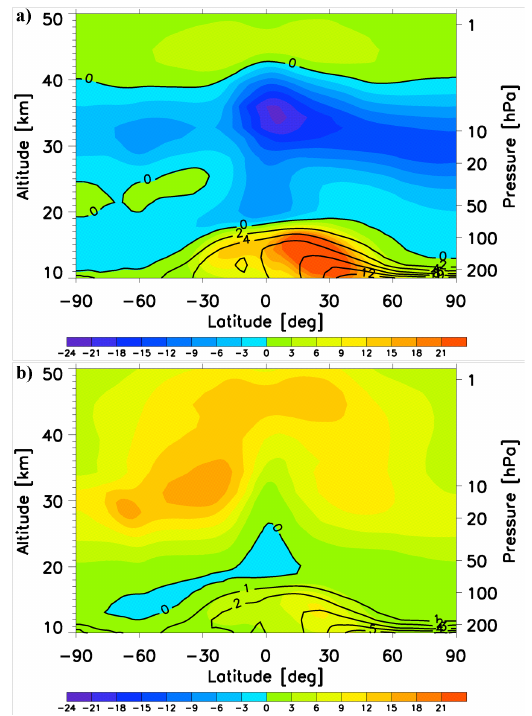
Figure 10. Annually, zonally averaged NO x concentration changes in units of pptv (shown by 2 Fig. 10. Annually, zonally averaged NO x concentration changes in color) and the relative change in % (shown by contours) in the H 2 -ICE scenarios compared 3 units of pptv (shown by color) and the relative change in % (shown with the BL scenarios as a function of latitude and altitude for (a) A1FI and (b) B1 scenarios. 4 by contours) in the H 2 -ICE scenarios compared with the BL sce- narios as a function of latitude and altitude for (a) A1FI and (b) B1